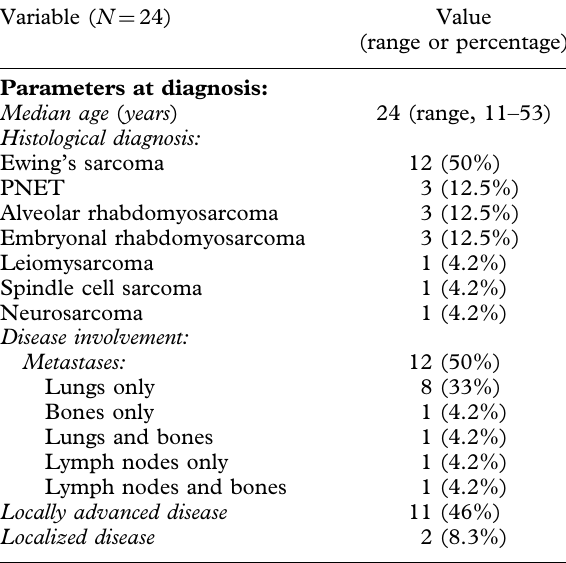
Table 1. Patient characteristics at time of